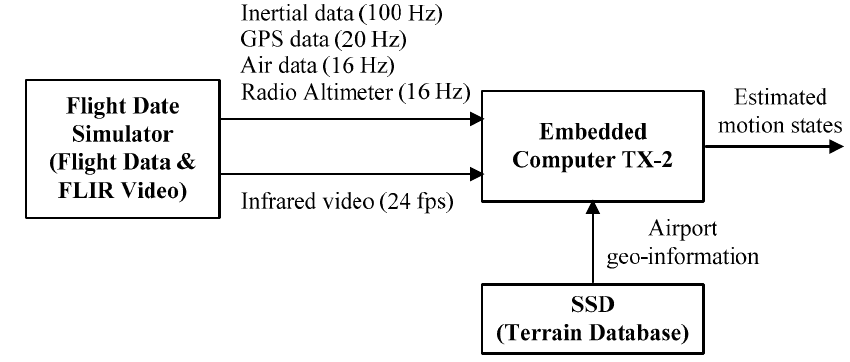
Figure 8. The block diagram of the experimental platform.